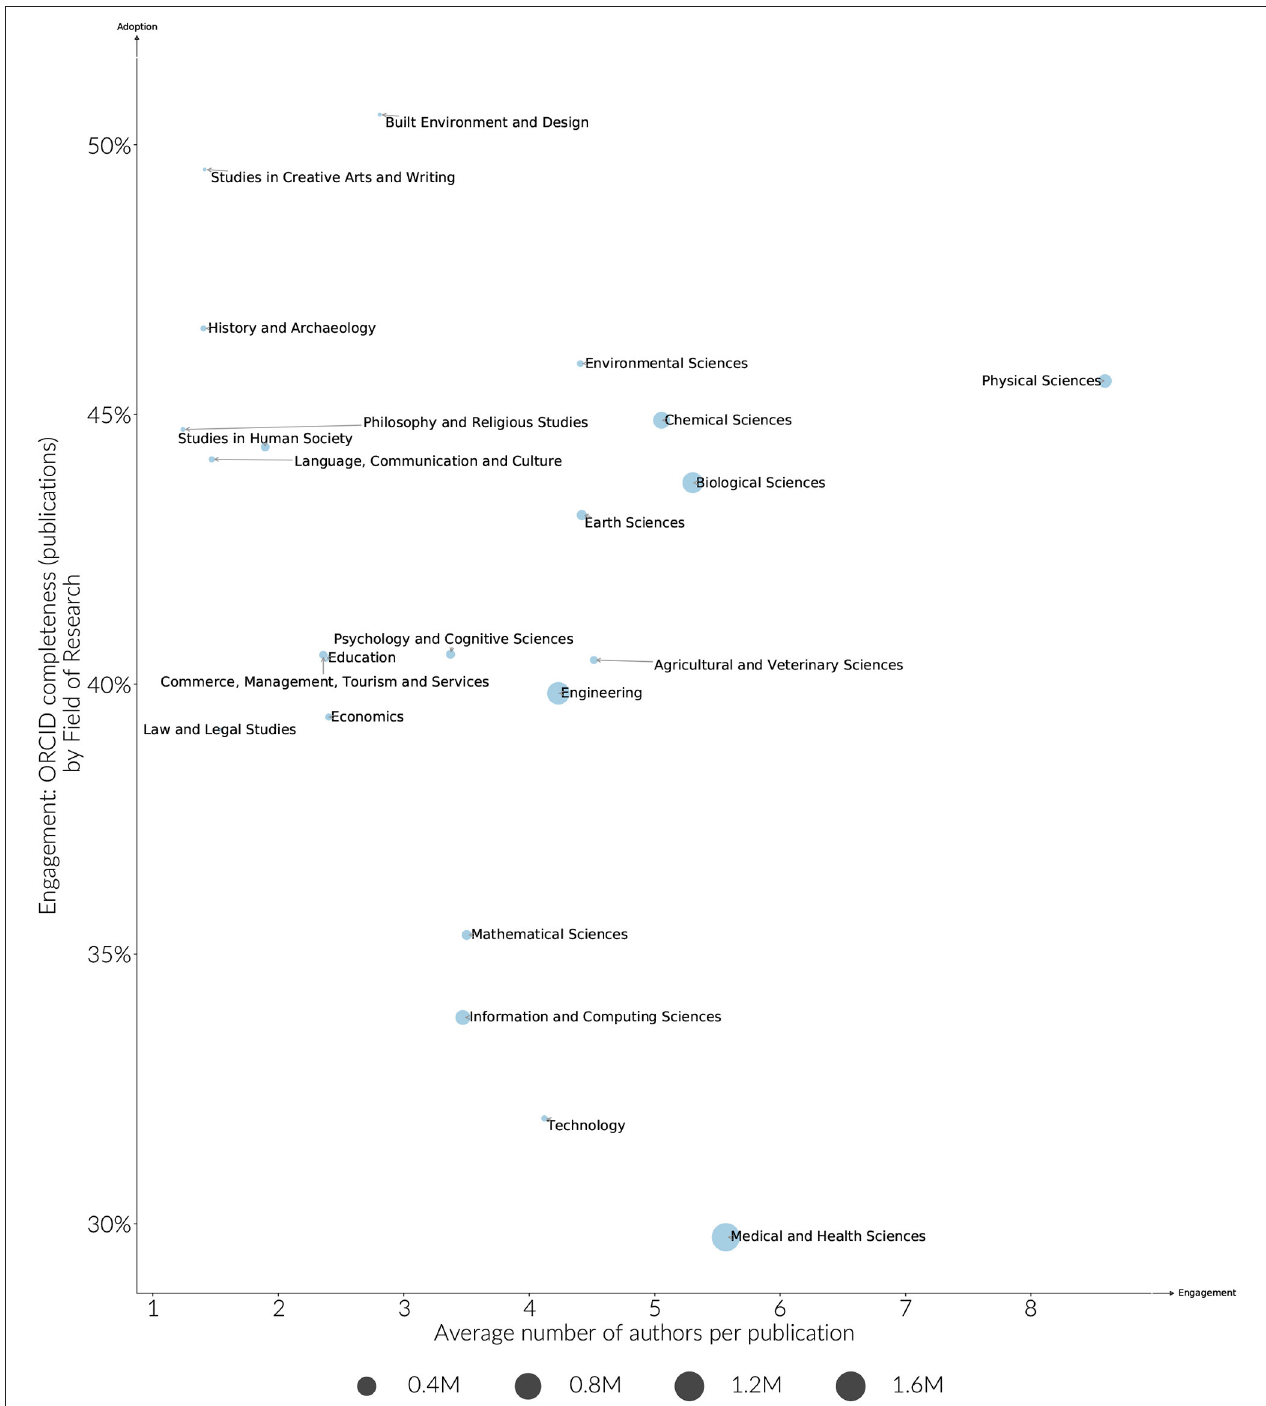
FIGURE 7 | Estimated engagement by Field of Research compared to the average number of authors per paper. Researchers are included if they have > 5 years publication history, publications (2015–2019). The size of the marker indicates the size of the identified researcher